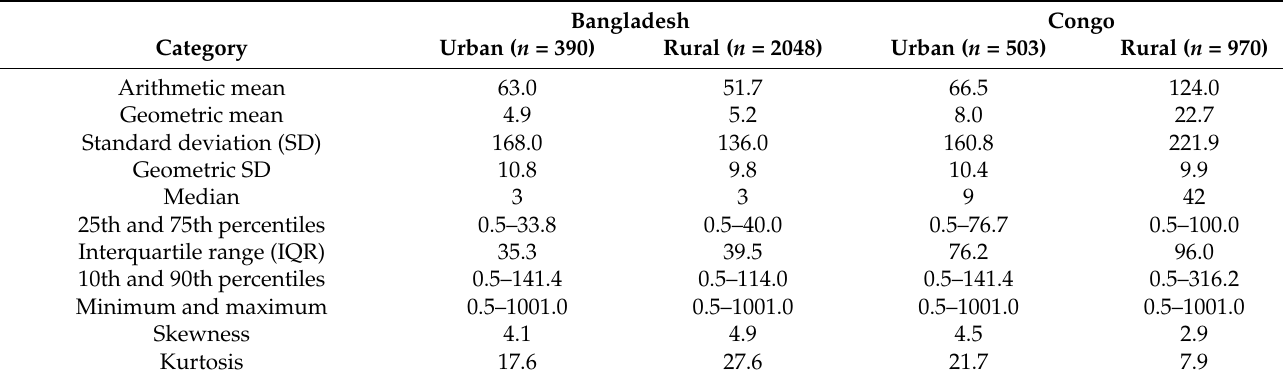
Table 2. Descriptive statistics for fecal indicator bacteria (FIB) concentrations in urban and rural areas for Bangladesh and Congo datasets.